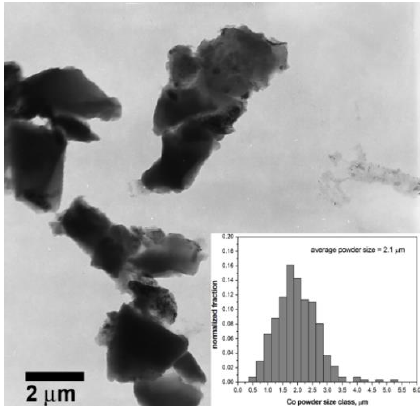
Figure 1. TEM (transmission electron microscope) extraction image showing the cobalt starting powder dimension; inset shows the powder size distribution obtained from 350 measurements performed on TEM.